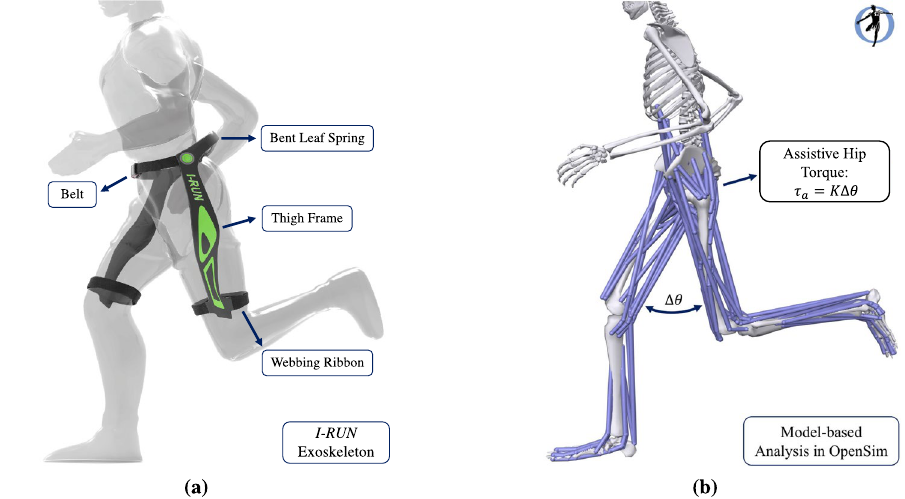
Figure 1. Description of I-RUN . ( a ) describes the functionality of I-RUN 1,2 . Using I-RUN resulted in on average 8% metabolic rate reduction in ten healthy active subjects at 2.5m / s running speed. ( b ) shows our model-based approach for evaluating the efficacy of the I-RUN torque profile in OpenSim software 3 . Since the I-RUN torque is a linear function of the difference between hip angles, we have modeled it as τ a = K �θ , where τ �θ is the difference between left and right hip angles, and K is the a represents the assistive torque,